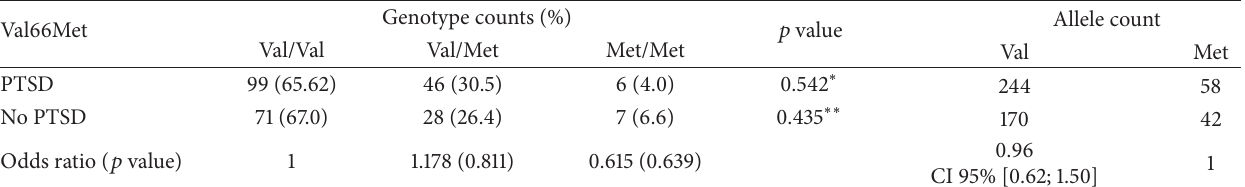
Table 3: Association of genotype frequencies of BDNF Val66Met for participants with and without PTSD.